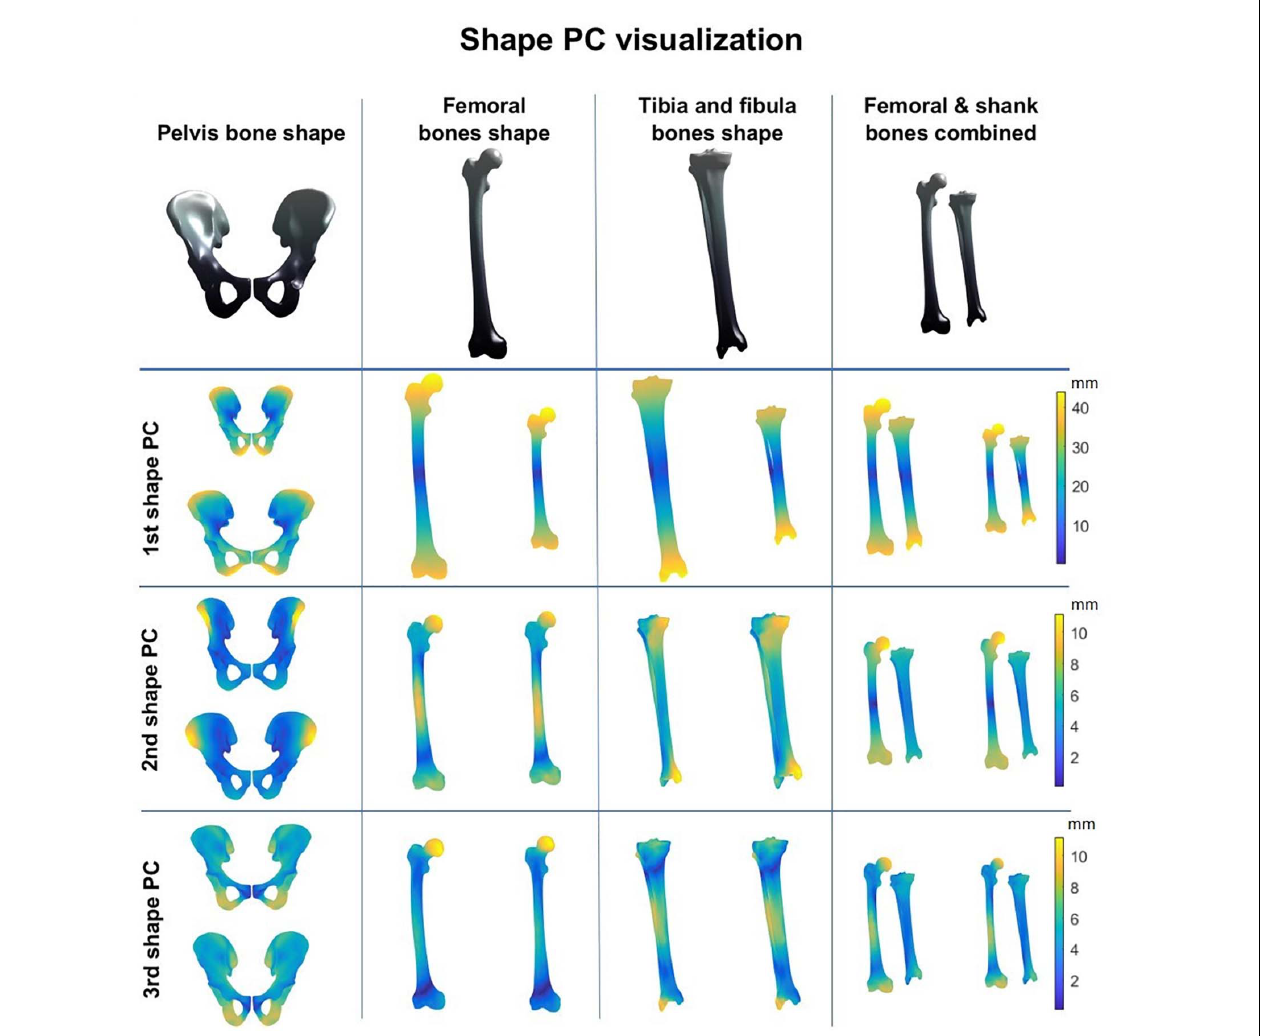
FIGURE 3 | Shape modes from the personalized bone shape models of pelvis, femur, shank (tibia + fibula), and femur and shank combined. Averaged geometry is displayed at the top while variation is represented with a color scheme (average shape ± 3 standard deviations of the shape principal components).